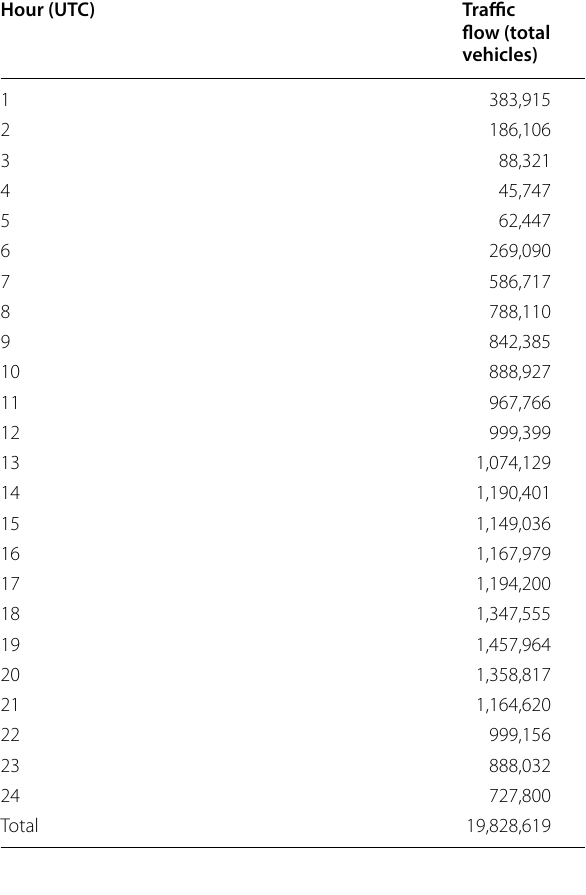
Table 1 Hourly frequency of total traffic flow in 2018, after the total hour-by-hour detector of total vehicles in the study area